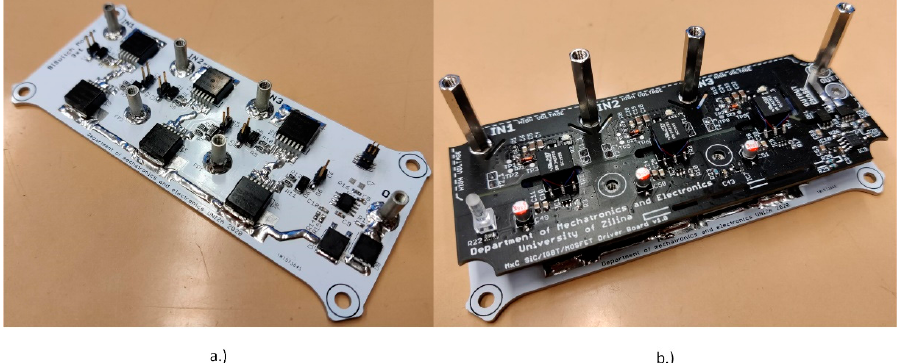
Figure 19. ( a ) Power module on IMS boars ( b ) Assembled power module and driver board.